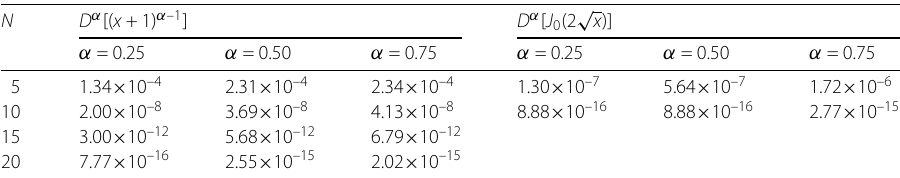
Table 1 Accuracy of Legendre spectral derivative of the different orders for two functions ( x + 1) α –1 √ and J 0 (2 x